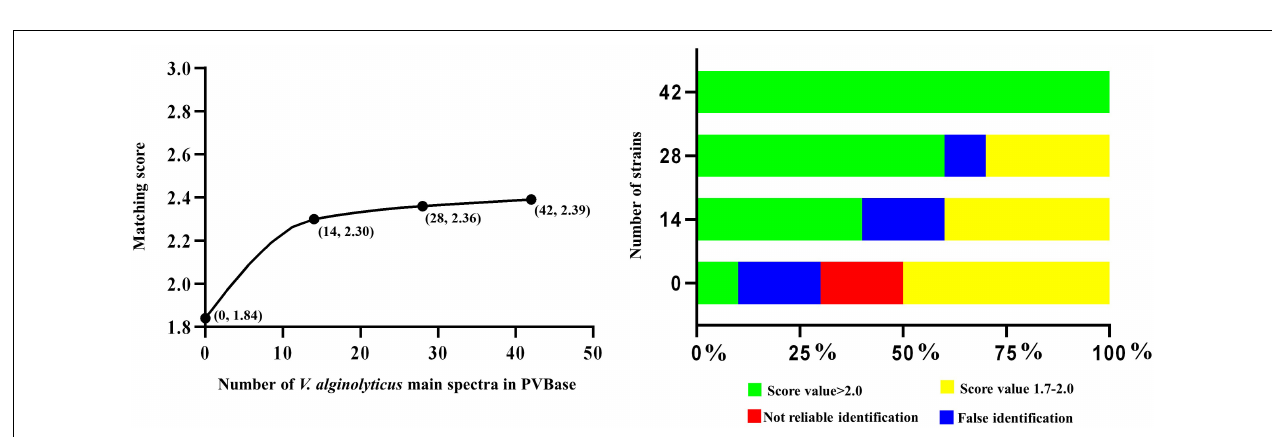
FIGURE 3 | Correlation between number of main spectra for V. alginolyticus archived in the PVBase and the highest expected matching score or identification accuracy.